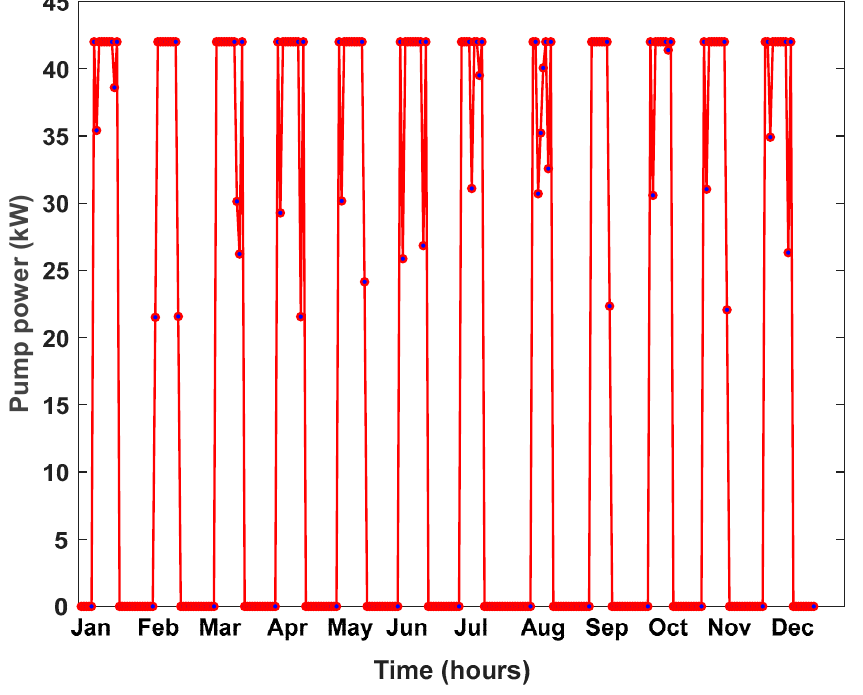
Figure 8. Pump power demand profile.